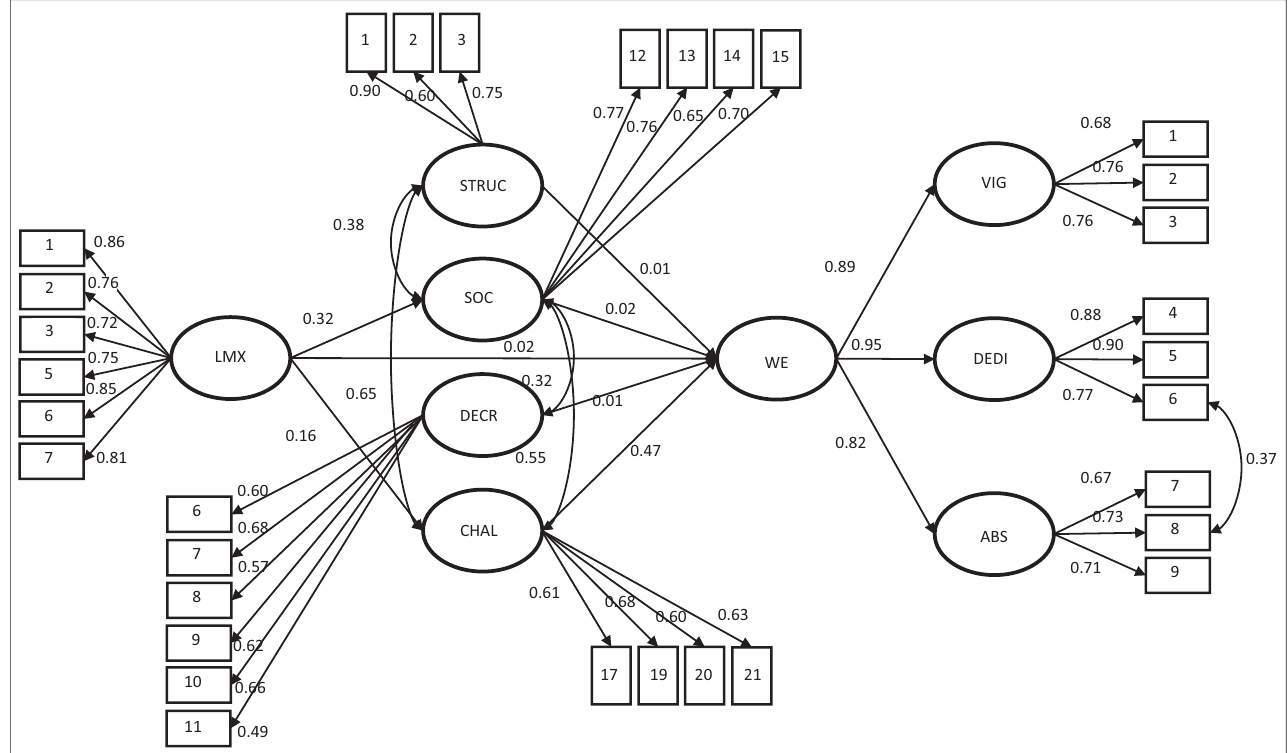
FIGURE 1: Overview of the structural